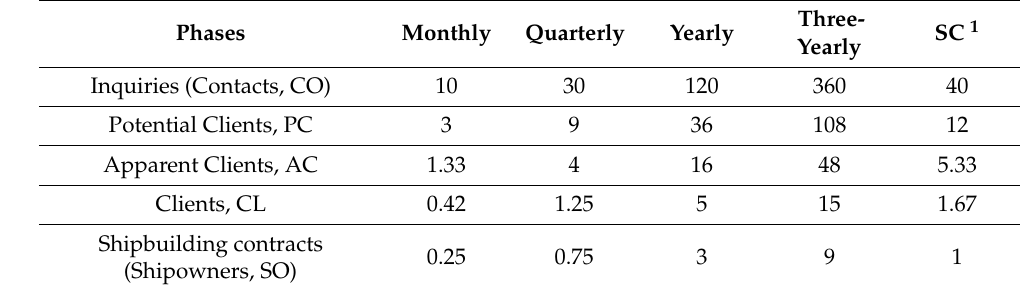
Table A10. The average number of the “shipyard—customer” interactions by conversion phases—the future